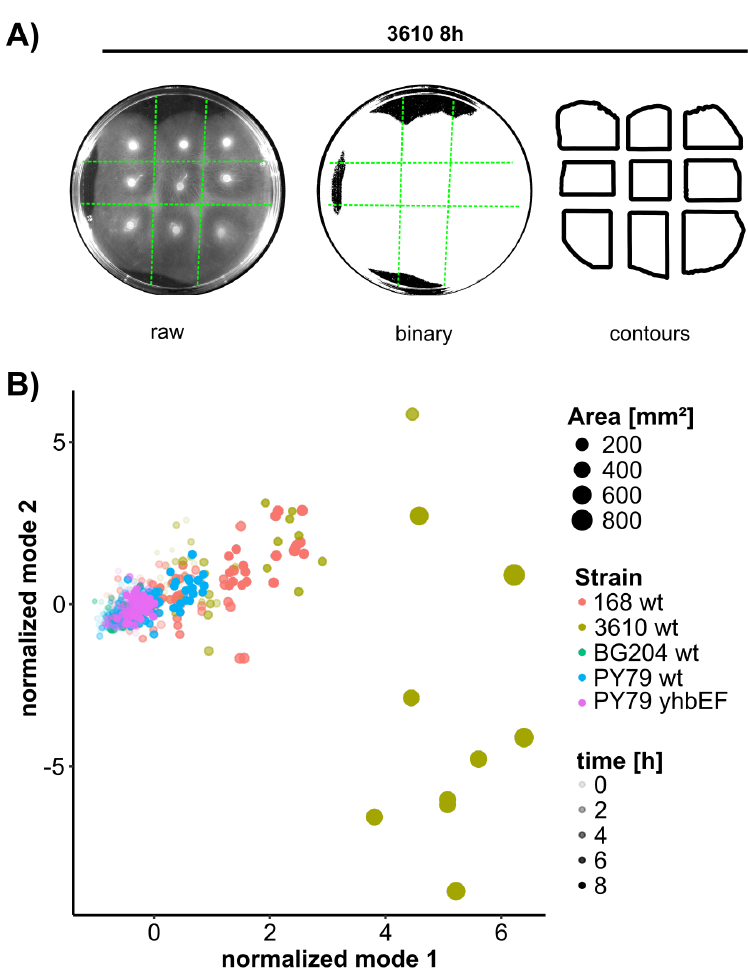
Figure 3. ( A ) Processing of an overgrown soft-agar plate. B. subtilis W3610 rapidly spreads over the surface of soft-agar plates and single colony borders are not distinguishable after 8 h. To approximate the area, the plate was sectioned, and threshold was adjusted manually. ( B ) Colony data plotted based on the shape variance (normalized model 1 and 2) of their contours that are extracted and measured from binary images using celltool [14]. The distribution of colony contour shape gives additional information on the motility and shape differences between B. subtilis strains PY79 (blue), 168 (red), BG214 (green), W3610 (olive-green) and the flagella-deficient strain PY79 yhbEF on soft- agar plates. Colony area is indicated by the size of the spots in the plot and time of detection is indicated by the transparency, with the most transparent spots being acquired at 0 h and the most dense spots being acquired at 8h. Figure created using Inkscape 0.92.3, available at: https: //www.inkscape.org (accessed on 15 September 2022) and the R-package ggplot2 [21] available at: https://ggplot2.tidyverse.org (accessed on 15 September